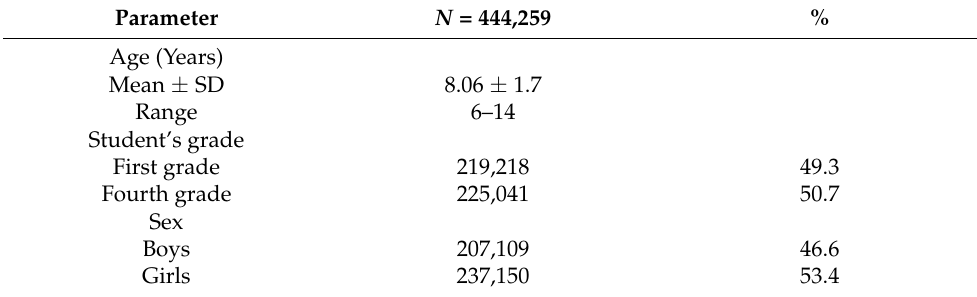
Table 1. The frequency distribution of students in relation to educational grade and